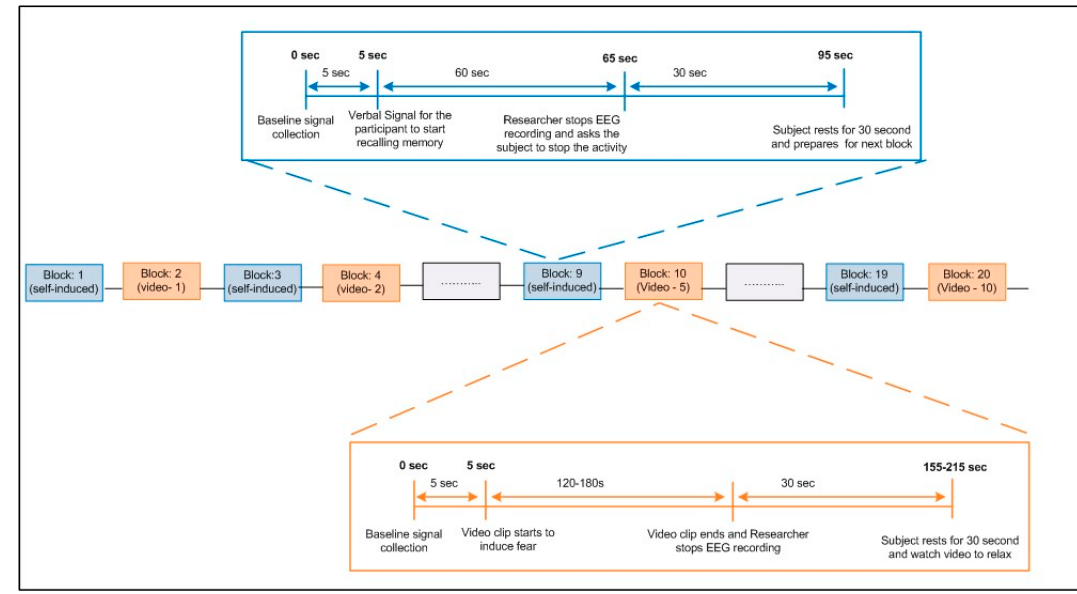
Figure 2. Block diagram of the experiment. EEG—electroencephalography.